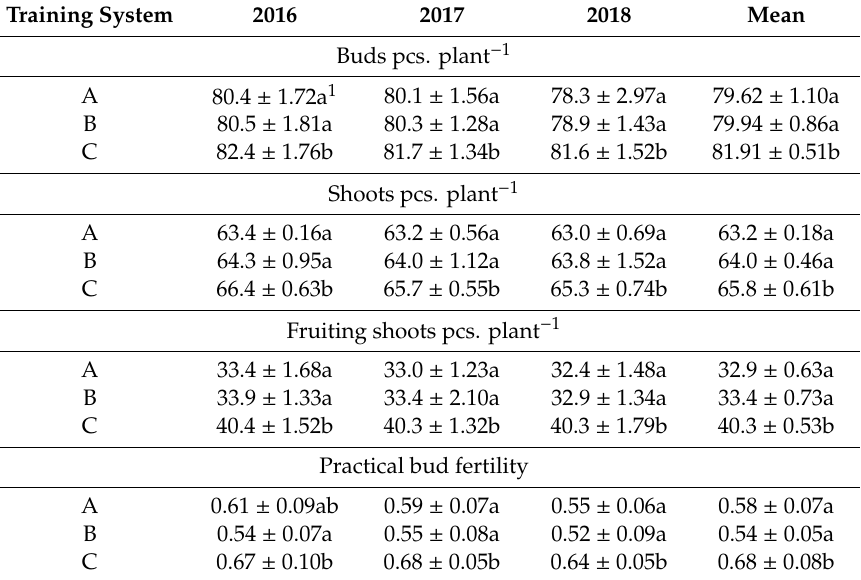
Table 3. Vegetation and growth indicators with dependence on the training systems